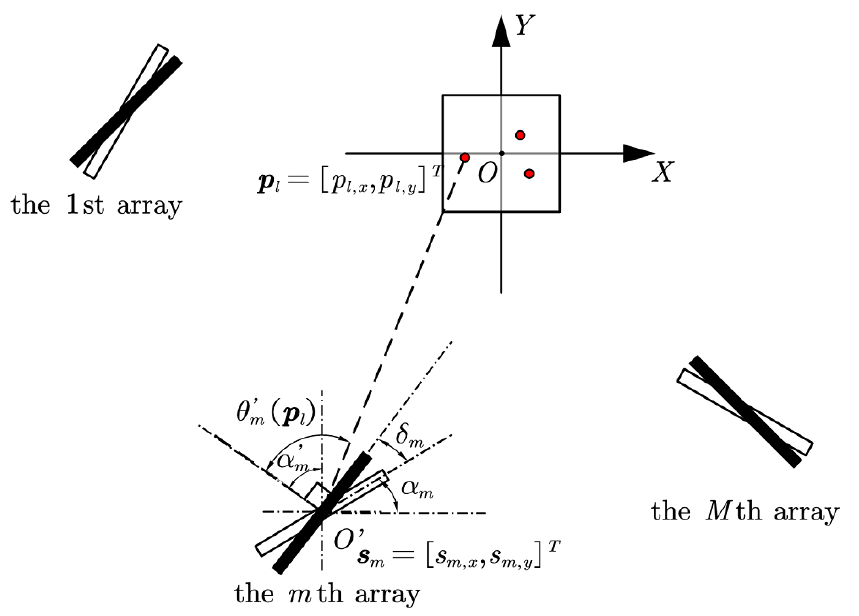
Figure 1. The geometry of the emitters and arrays in the XOY plane. White blocks, black blocks, and dots represent the actual, pre-assumed deployment of arrays, and positions of emitters,